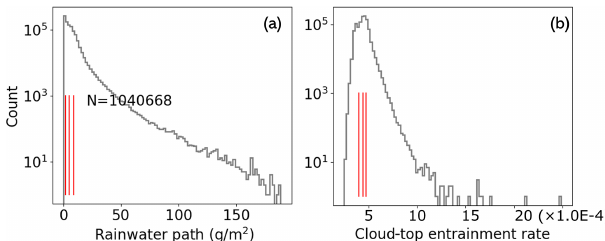
Figure 3. Histogram of the counts of the rainwater paths (a) and of the cloud-top entrainment rates (b) in the RAMS cloud profiles; the red vertical lines from left to right indicate the 25th, 50th, and 75th percentiles. A profile is defined as strongly precipitating (SP) when the rainwater path exceeds the 75th percentile and as weakly precipitating (WP) when the rainwater path remains below the 25th percentile. Similarly, a profile is considered and defined as strong cloud-top entrainment (SE) when the entrainment rate at the cloud top exceeds the 75th percentile and as weak cloud-top entrainment (WE) when the entrainment rate at the cloud top is less than the 25th